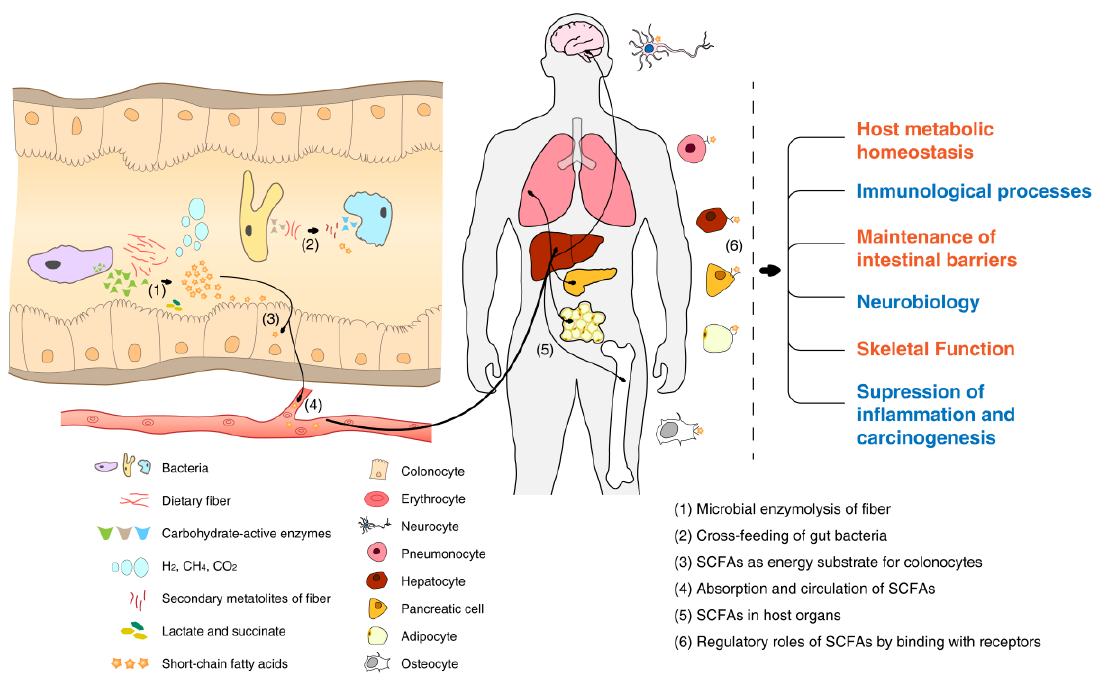
Figure 2. Fermentation of dietary fiber by gut microbiota.